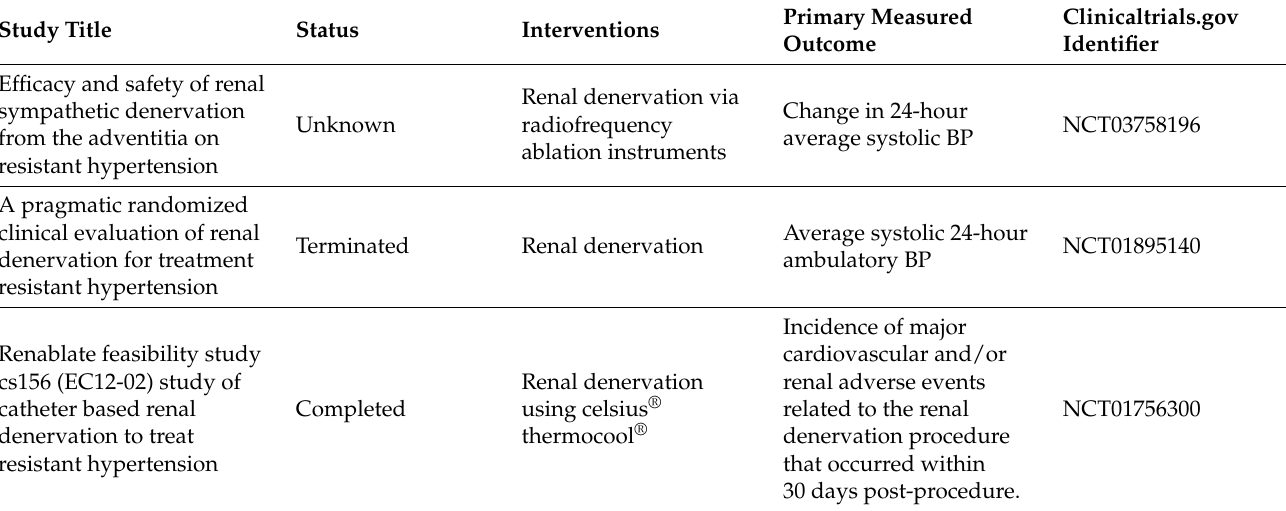
Table 2. Clinical trials involving surgical treatments for drug resistant